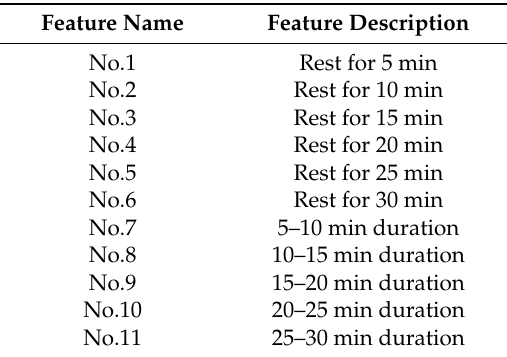
Table 2. Features of the health